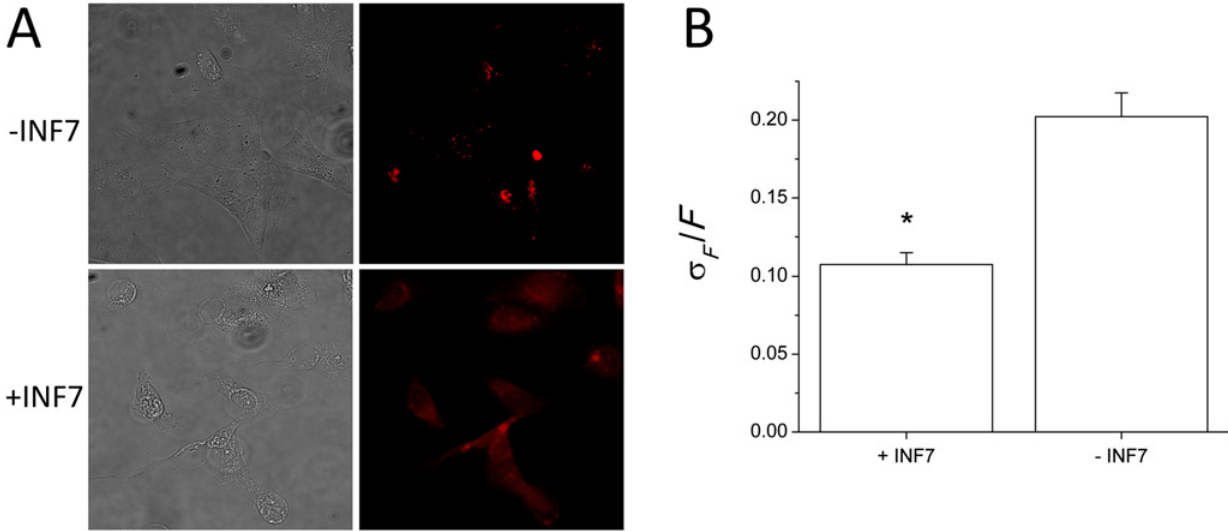
Fig 8. INF7 mediates release of endosomal RD into the cytosol. A. Liposomes containing RD with or without INF7 were incubated with CV1 cells for 1 hr, washed to remove un-endocytosed liposomes, and incubated for an additional 2 hr. RD fluorescence appears more evenly distributed throughout